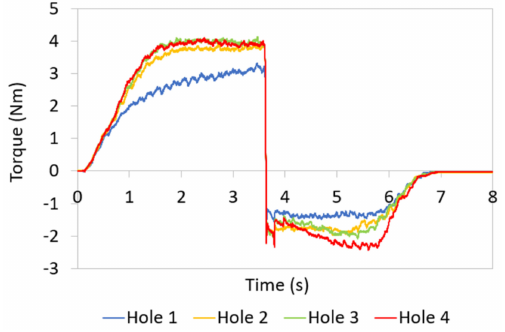
Figure 6. Set of typical torque results obtained for tapping a sequence of 4 holes using